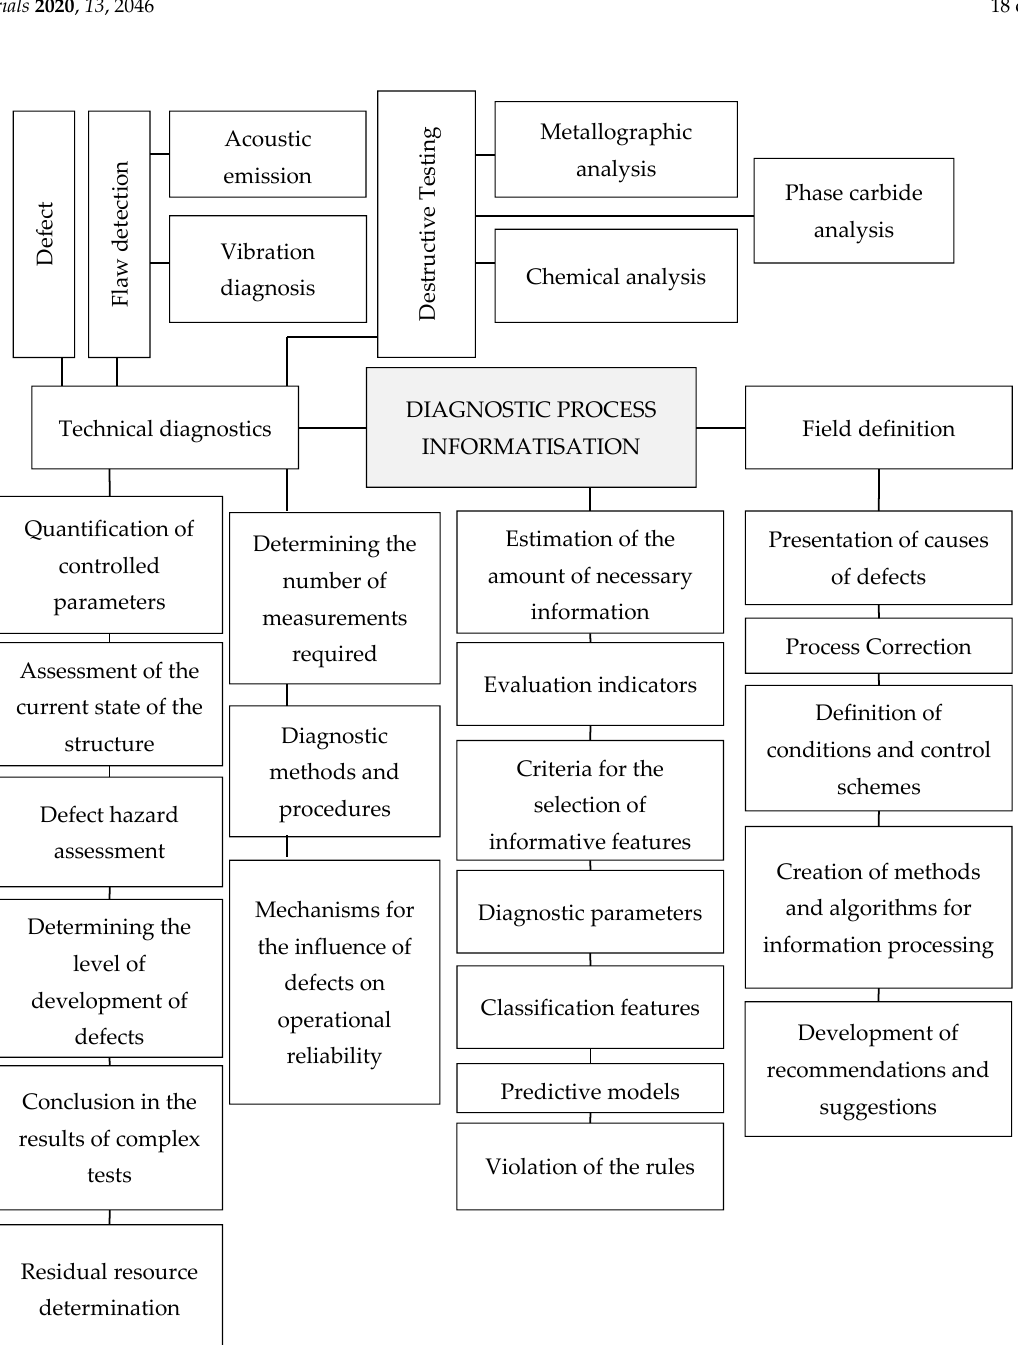
Figure 22. The functional purposes and components of the informatisation of the diagnostic process.